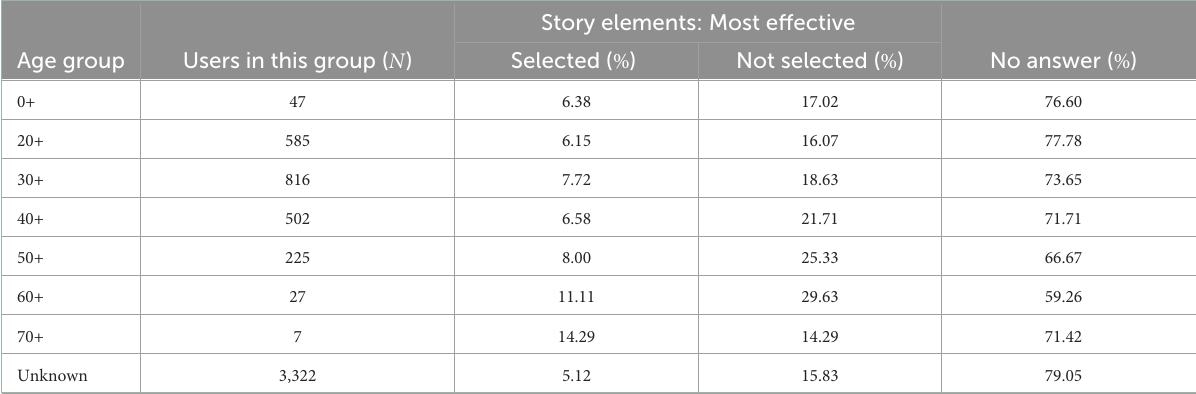
TABLE 7 Answers for each age group in the post course survey in the java2018 course with ratio of learners that selected the story elements as most effective compared to those that did not select this option (Hagedorn et al., 2022). Story elements: Most